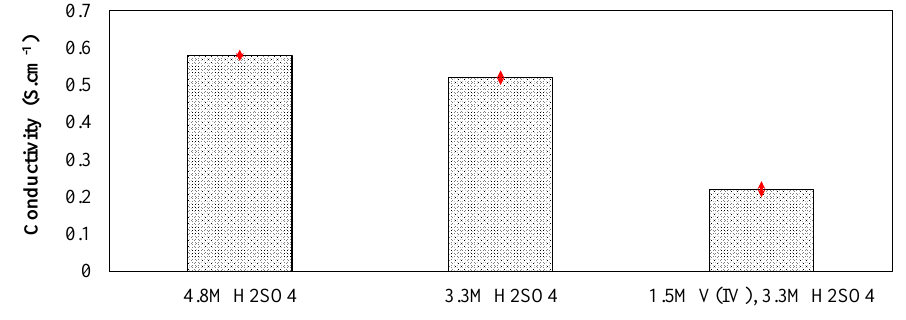
Figure 5. The ionic conductivity measured for various electrolytes.